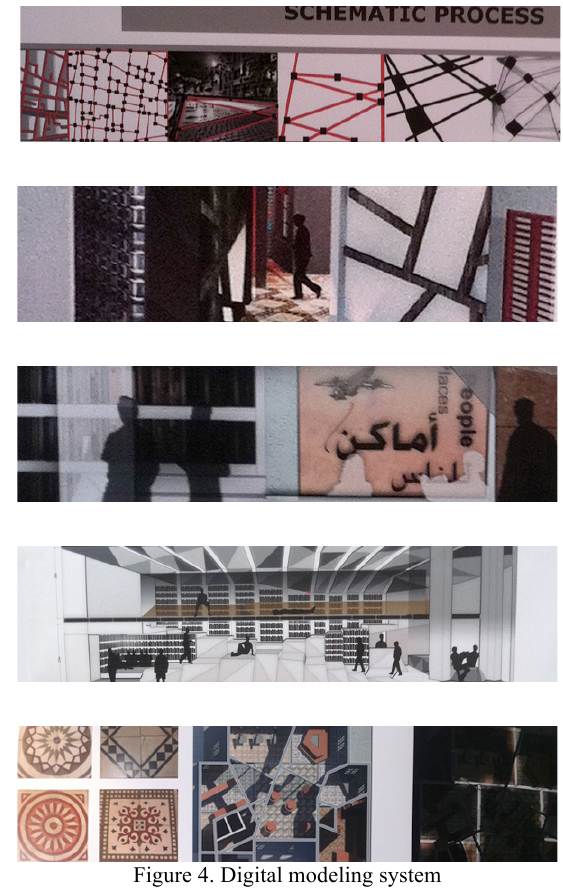
Figure 4. Digital modeling